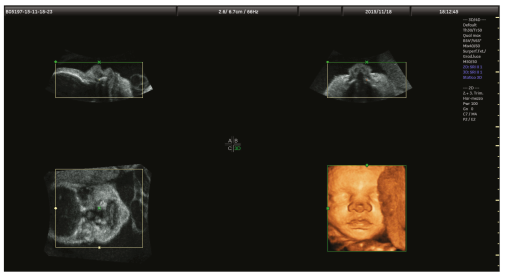
Figure 1: Screenshot of a 4D View application by GE Healthcare ’ s Voluson.